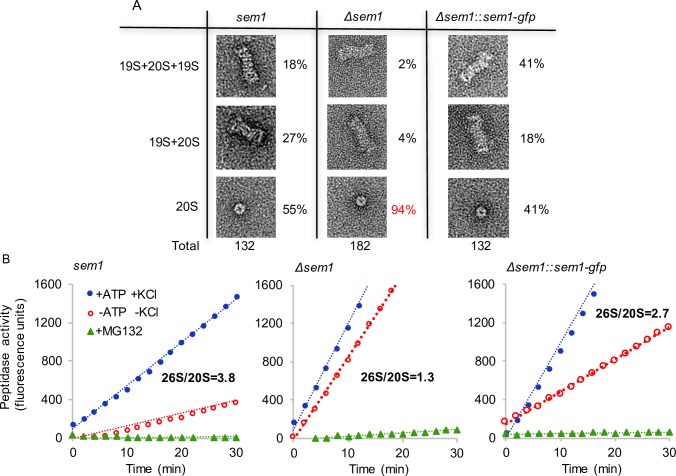
Accumulation of 20S proteasome complexes in Δsem1.(A) Electron micrographs of negatively stained proteasome complexes derived from fungal cell extracts. The total numbers of proteasome complexes and the respective complexes observed (%) in Δsem1, wildtype (sem1) or complemented (Δsem1::sem1-gfp) strains are indicated. (B)
Δsem1 proteasomes showed similar peptidase activities regardless to the presence or absence of ATP and KCl. Activities were measured in assay buffer containing 0.125mM ATP, 10mM KCl and 2.5μM of the proteasome inhibitor MG132. The assay buffer also contained 12.5 mM Tris HCl pH = 7.5 +1.25 mM MgCl2 +0.25 mM DTT+0.0125 mg/ml BSA. Blue, red and green curves represent peptidase activity of the indicated strains in the presence of ATP+KCl (26S activity), in the absence of ATP and KCl (-ATP–KCl, 20S) and in the presence of MG132 (proteasome inhibitor).